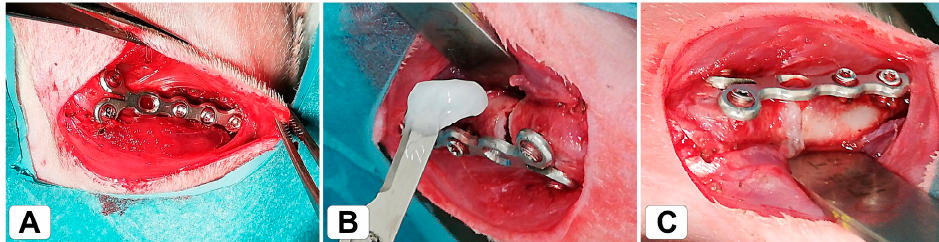
Figure 1. Distal right metaphyseal osteotomy model. ( A ) Macroscopic plate fixation and ( B , C ) ap- Distal right metaphyseal osteotomy plication of alginate into the fracture gap.